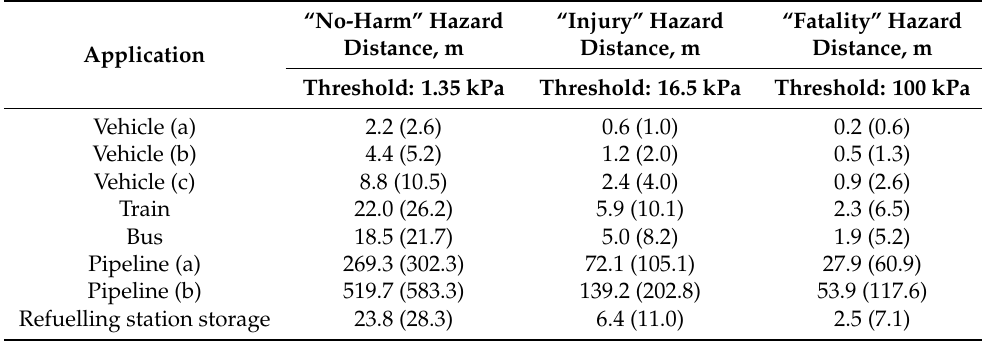
Table 4. Hazard distances from the center of the fast-burning mixture, defined by harm thresholds in [29,30], for the considered examples of application using the conservative correlation in Equation (5). The letters (a)–(c) stand for different release scenarios associated to a same example of